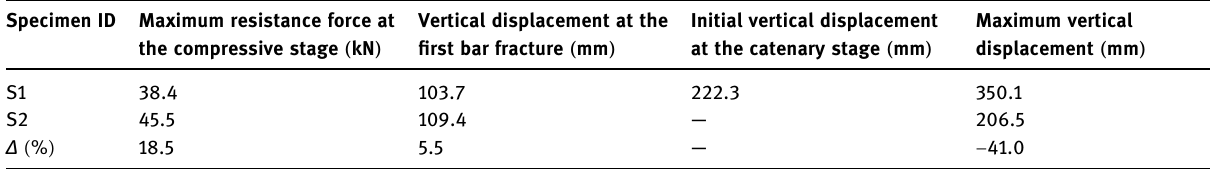
Table 5: Comparison of the test results